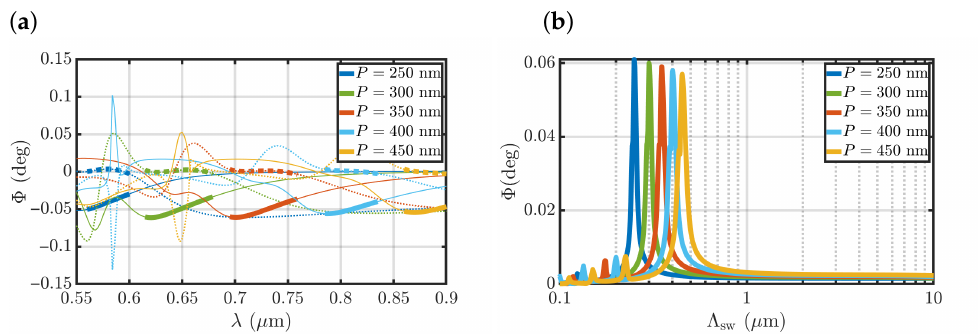
Figure 4. Tuning metasurface parameters to perform sensing. ( a ) Spectra of the polar Kerr effect Φ for the uniform magnetization Λ ∞ (dotted line) and Λ sw = sw = P (solid line) calculated for several metasurface periods (see the legend). Regions corresponding to the selective MO sensing of Λ sw = P are shown by thick lines. The Si nanostripe width was kept equal to the structure half-period d Si = P /2 while its thickness gradually increased from h Si = 52 nm to h Si = 94 nm with the period increase. ( b ) Sensitivity of the polar Kerr effect Φ ( Λ sw ) for the metasurfaces with different periods (see the legend) for w = 6 µ m beam